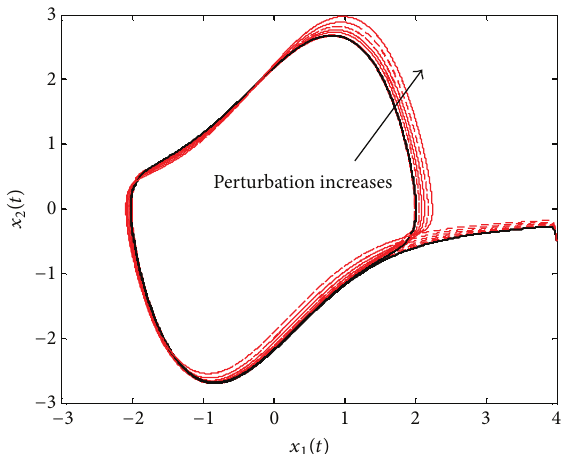
Figure 13: Error between 𝑦 2 (𝑡) and 𝑥 2 (𝑡) for different values for 𝜇